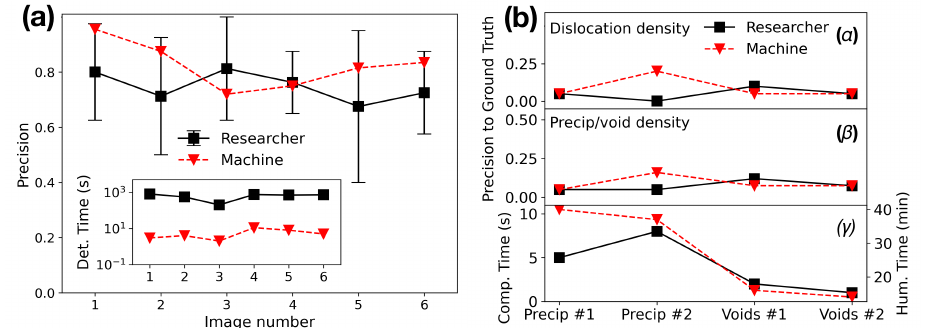
Figure 9. Human Vs. Machine in deformation microstructures. ( a ) A scientific software based on CNN is applied to quantify defects in materials. A comparison of the precision and time efficiency of both the human and machine labeling is presented. The image number corresponds to the selected one from the complete test set and error bars correspond to the minimum and maximum precision obtained by the five researchers. The selected images were also analyzed by five researchers (Redrawn based on results in Ref. [87]). ( b ) A modern electron microscopic system coupled with a CNN based scientific software is applied to directly analyze materials defects. This figure presents the comparison of materials evaluation metrics for defect quantification performed by computer and by expert researchers. Materials metrics include dislocation density in ( α ), and precipitates and voids number density in ( β ), the diameter and the time spent for computer and human experts to quantify these defects in ( γ ) (Redrawn, based on